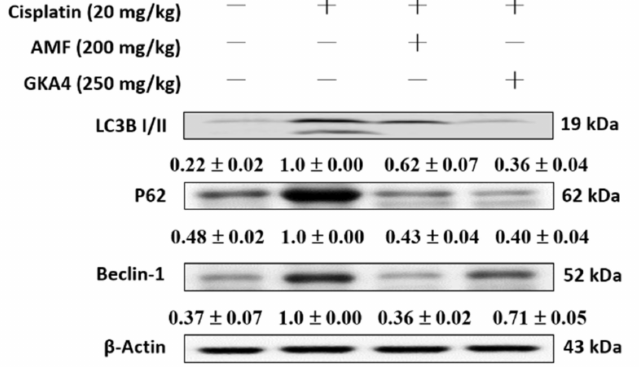
Figure 7. GKA4 diminished the expression of LC3B, P62, and Beclin 1 proteins after cisplatin exposure. Kidney tissue lysate was subjected to western blot analysis using antibodies specific to LC3B, P62, Beclin 1, and β -actin. Protein bands were analyzed by densitometric analysis. Experiments were repeated at least three times, and representative images are shown. Plus signs: with drug; Minus signs: without